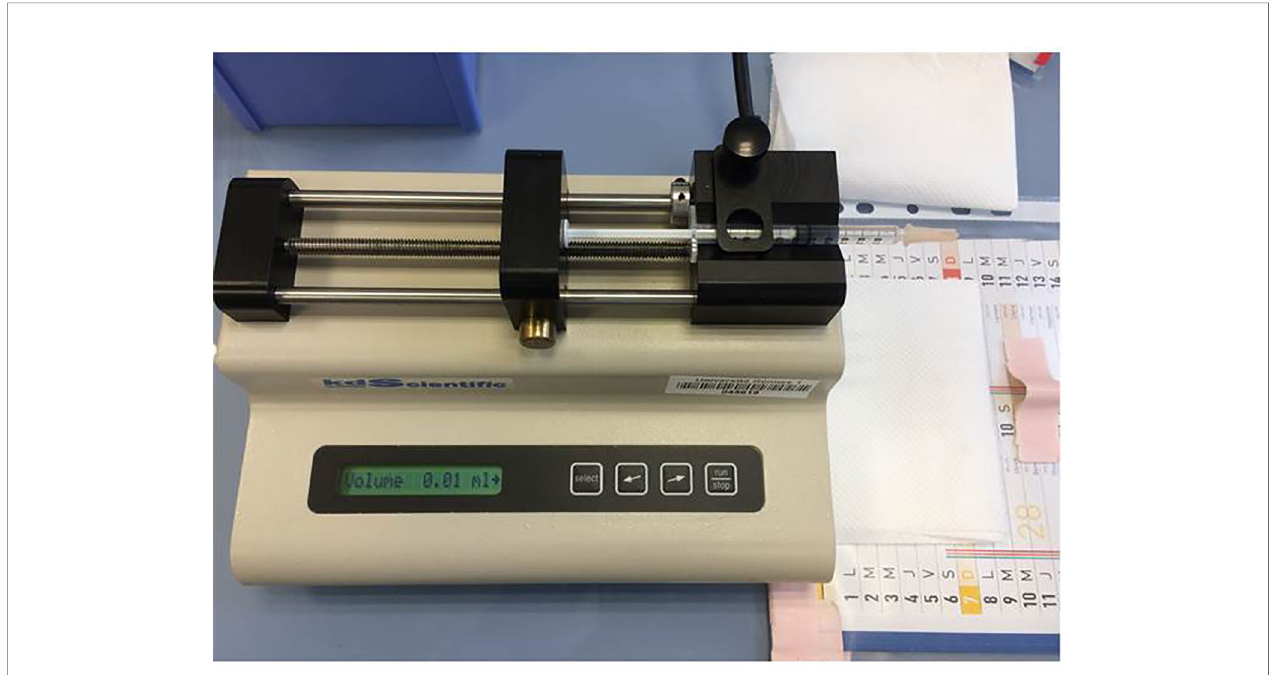
FIGURE 4 | Microinjector (KDS 100 automated syringe pump, KD scienti fi c) with a calibrated 0.3 ml